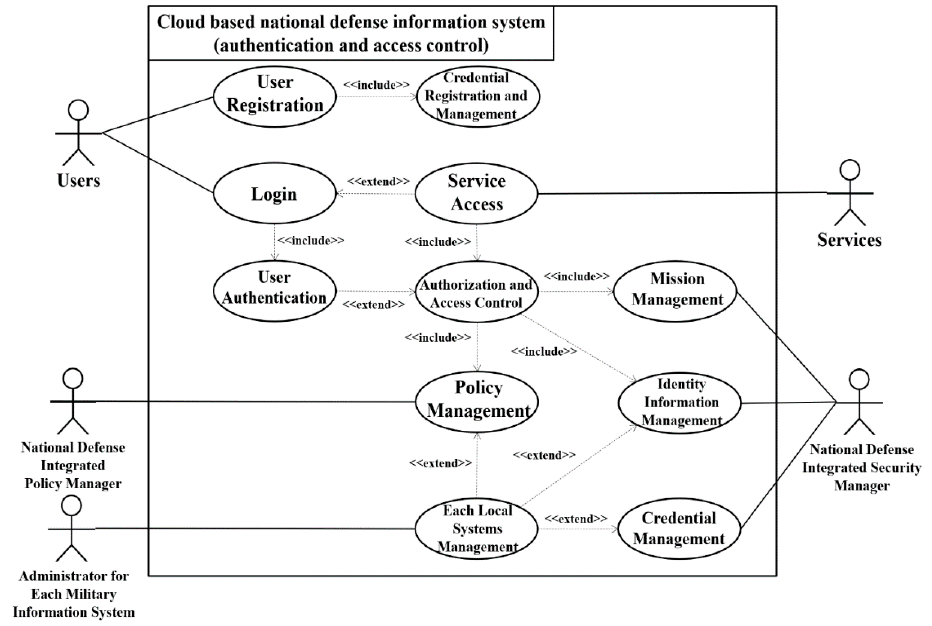
Figure 4. Authentication and Access Control Use Case Diagram for Cloud-based C4I System.